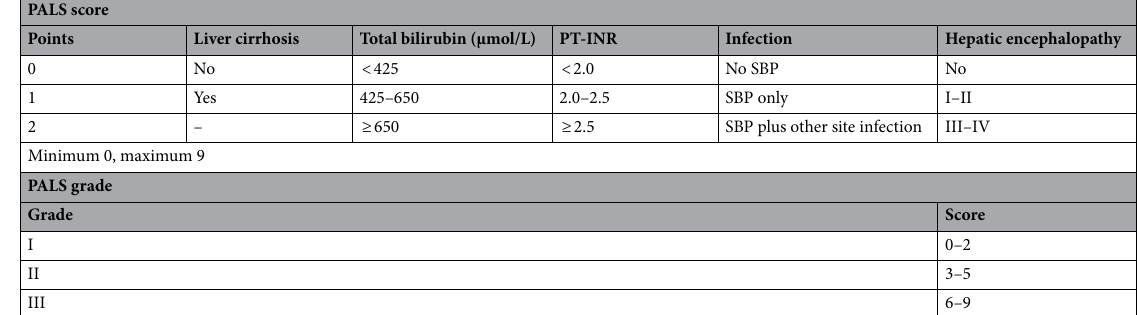
Table 4. PALS score and PALS grade. PALS score predictive score of short-term prognosis for patients treated with artificial liver support system therapy, PALS grade grade of PLAS score, PT-INR international normalized